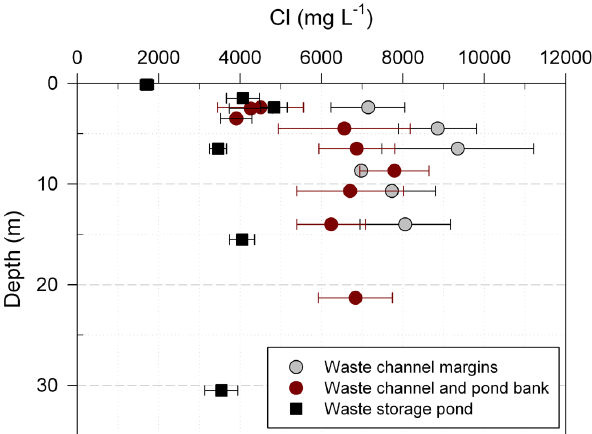
Fig. 6. Vertical distribution of Cl − concentrations in pore water from the vadose zone beneath the waste channel margins, the waste channel and storage pond banks, and the storage pond. Results are presented as averages, and the horizontal bars are the standard de- viation between all the water samples collected by each VSP (Ta- ble